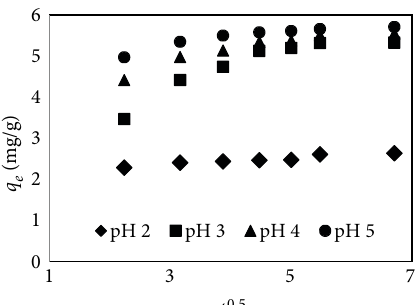
Fig. 10. Graphs of Weber-Morrisi for biosorption of Cu 2+ ions onto tobacco